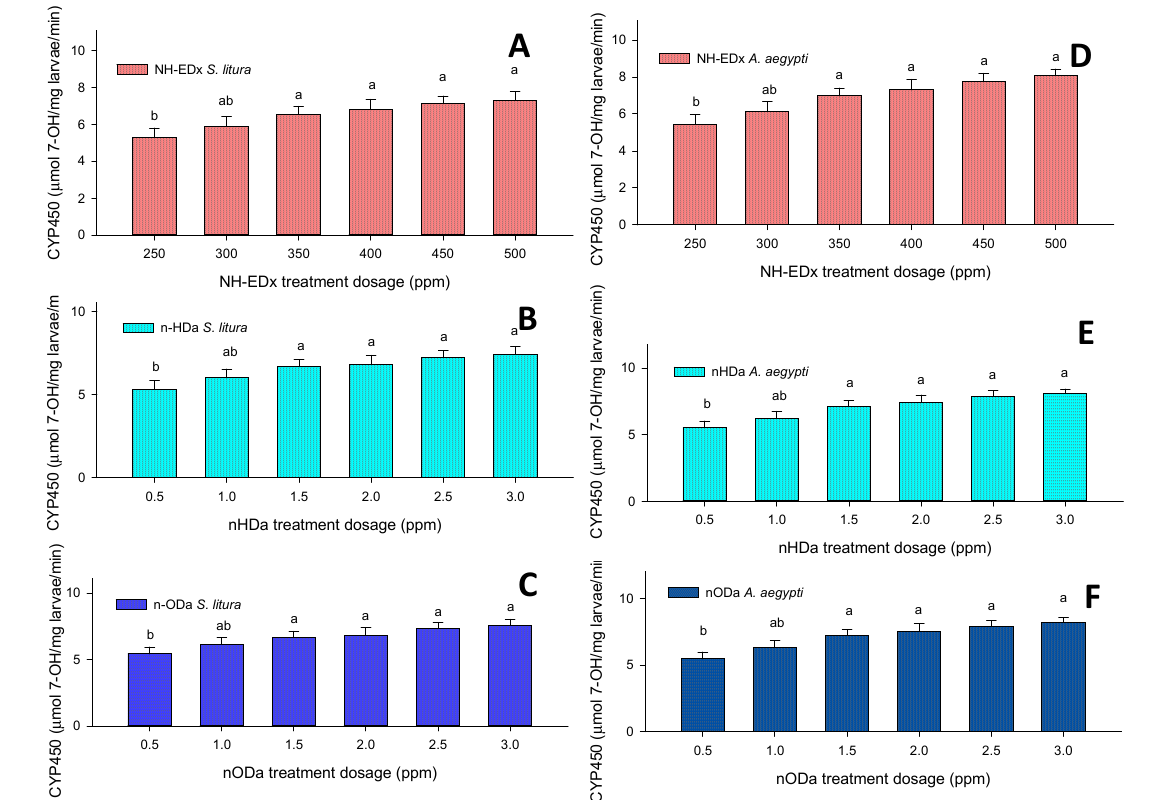
Figure 10. CYP450 enzyme activity of the fourth instars of S. litura after treatment with ( A ) NH-EDx, ( B ) n -HDa, and ( C ) n -ODa and of fourth instars of A. aegypti after treatment with ( D ) NH-EDx, ( E ) n -HDa, and ( F ) n -ODa, respectively. The data were fitted on a polynomial (regression) model. Vertical bars followed by letters indicate standard error (±SEM).